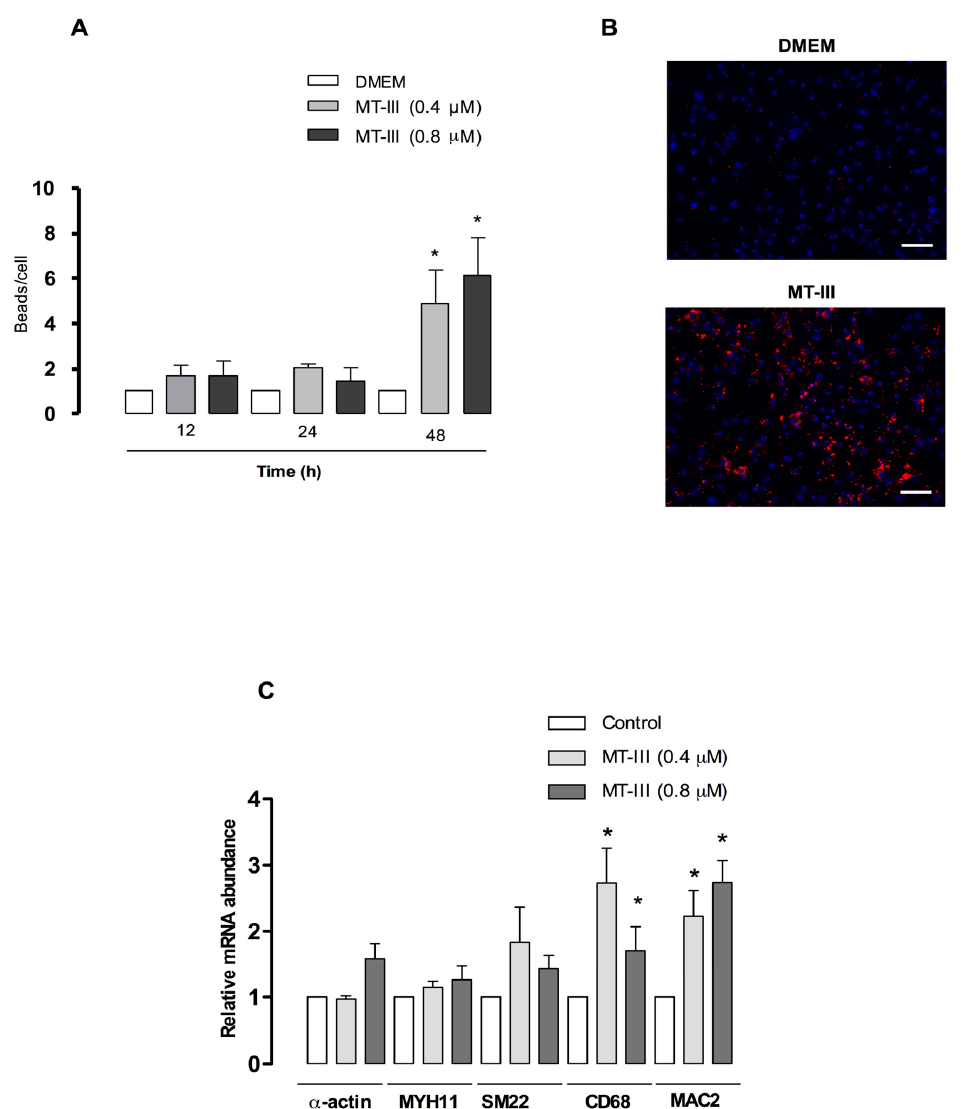
Figure 10. Phagocytotic activity and upregulation of macrophage markers in VSMCs induced by MT-III. VSMCs (2.5 × 10 3 cells / well) were treated with MT-III (0.4 and 0.8 µ M) or DMEM (Control) for 12, 24, and 48 h, followed by incubation with 0.5 µ m fluorescent beads (red) for 6 h. Cells were then washed extensively, fixed with paraformaldehyde (4%), counterstained with Hoechst 33342 (blue-nuclei), and analyzed with an automated Axiovert 200 m followed by a computerized automatic quantification in the CellProfiler analysis software. ( A ) The number of latex beads per cell was counted to obtain numerical data for the total phagocytotic activity. ( B ) A representative field of view. ( C ) The e ff ect of MT-III on VSMC and macrophage-related gene expression in rat VSMCs. Subconfluent rat VSMCs (8 × 10 5 cells / well) were treated with MT-III (0.4 and 0.8 µ M) or with DMEM medium (control) for 48 h. Total RNA was extracted and subjected to RT-PCR analysis. Values represent the mean ± SEM from six animals ( n = 6) (ANOVA). Note: * p < 0.05 compared with control